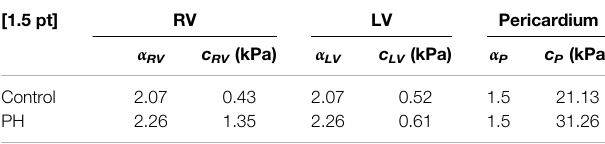
TABLE 1 | Estimated passive properties of the RV, LV, and pericardium for the control and PH rat heart models.